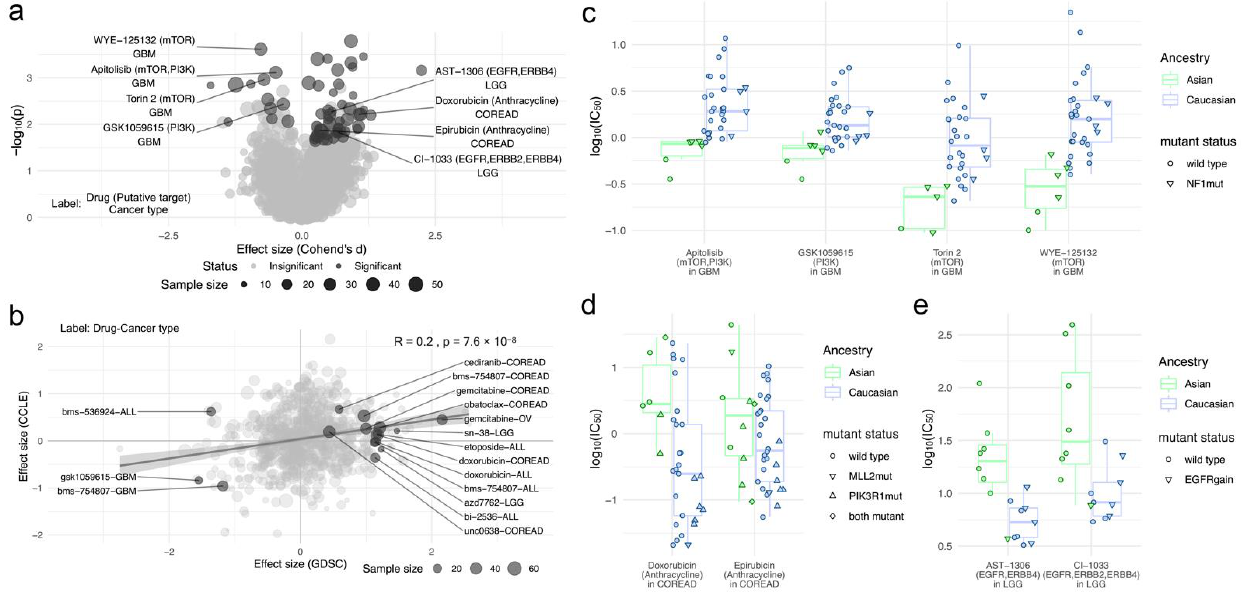
Figure 3. Differential drug responses between ancestral origins. ( a ) Associations between Caucasian and Asian ancestry and drug response across cancer types (<20% FDR). ( b ) Comparison of effect sizes between GDSC and CRTP. Highlighted are significant associations in GDSC, which were overlapping with CTRP. Here, the exemplified associations are higher drug sensitivity of ( c ) Asian CCLs to PI3K/mTOR inhibitors in GBM, ( d ) Caucasian CCLs to anthracyclines in COREAD and ( e ) Caucasian CCLs to TKIs in LGG.